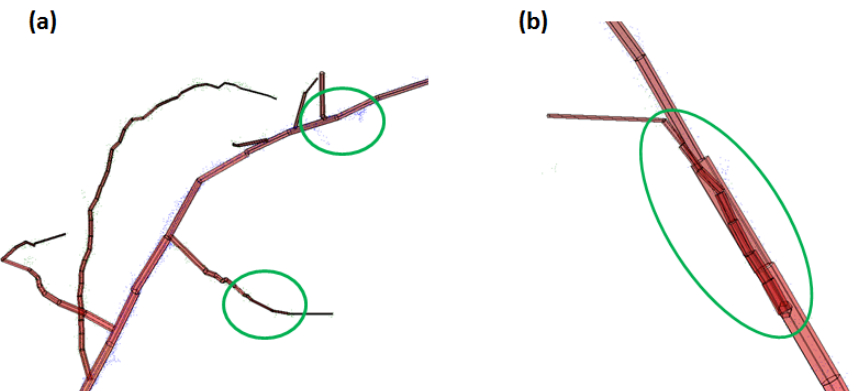
Figure 4. Error sources in the QSM, marked with green circles: ( a ) Branches shorter than 5 cm are poorly visible in the point cloud (blue points) and have been omitted by the model (no cylinder); ( b ) Some cylinders overlap in the model.